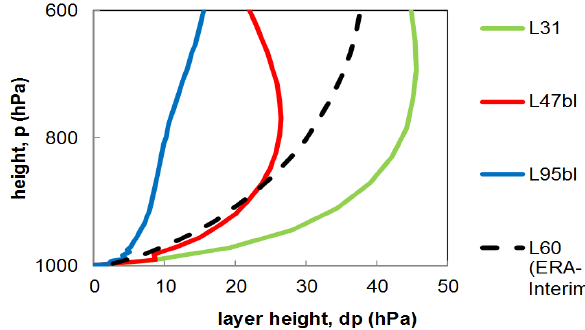
Figure 2. Vertical resolution of the reference L31 vertical grid and new L47bl and L95bl grids as well as the L60 vertical grid used in ERA-Interim. The (pressure) height of the model layers is shown as a function of the height above the surface for a surface pressure of